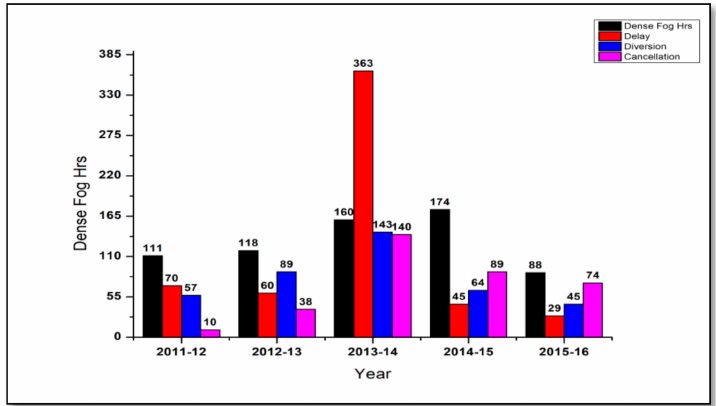
Figure 5. Number of total flights delayed (red), diverted (blue), and cancelled(pink) every year due to fog at IGI Airport, New Delhi. Black bar shows total number of dense fog hours for visibility less than 200